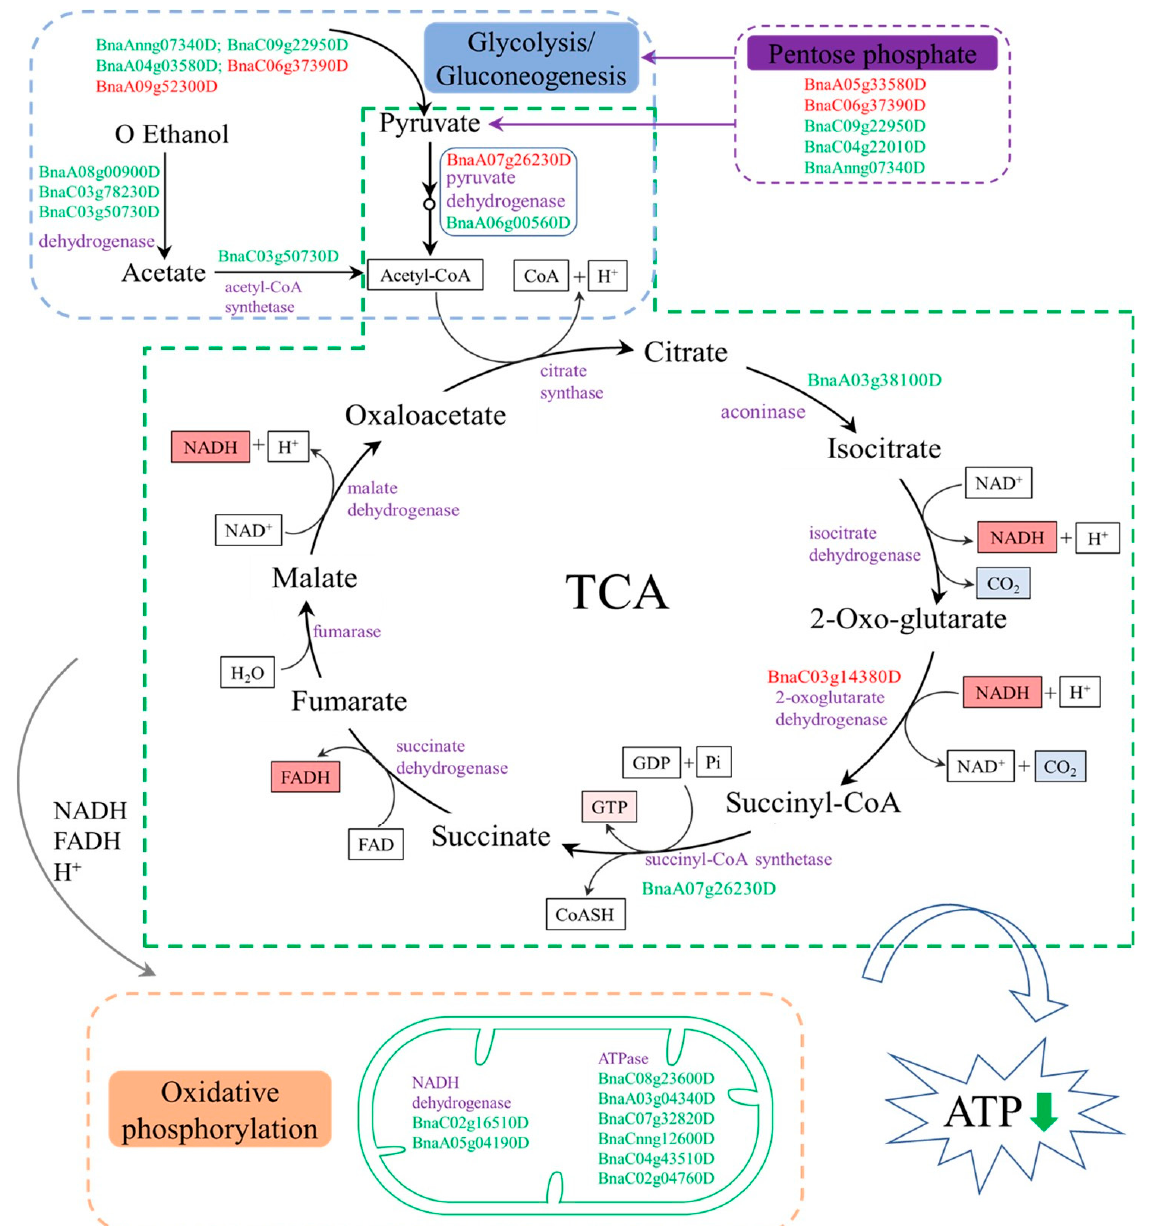
Figure 7. Differential abundance protein species (DAPs) involved in pathways related to carbohydrate and energy metabolism. Each pathway was surrounded by the dotted line in different colors. Purple words indicate the enzymes catalyzed in the relevant pathway. Red letters represent the upregulated and green letters represent the downregulated protein in inap CMS.